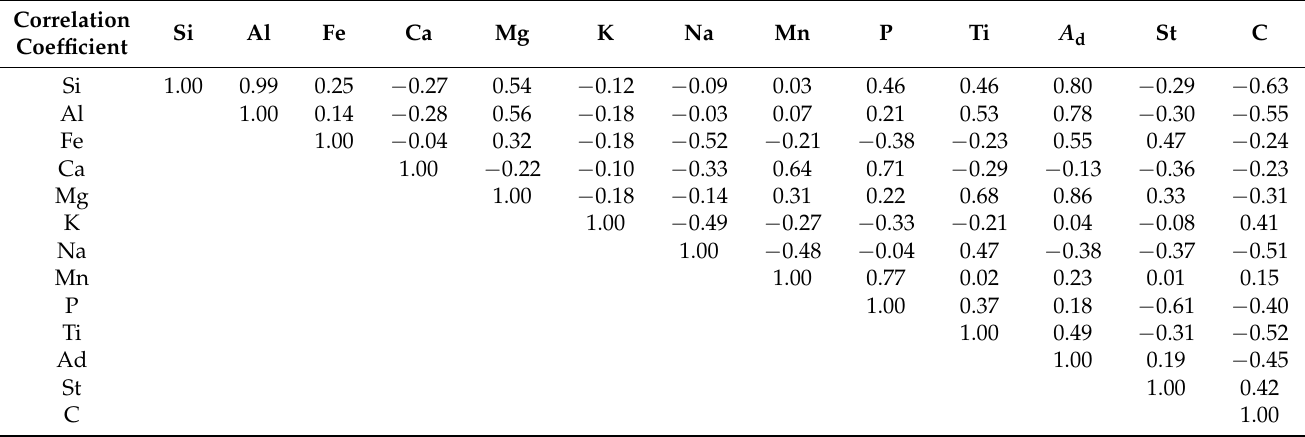
Table 3. Correlation coefficient analysis of major elements of No. 8 coal.